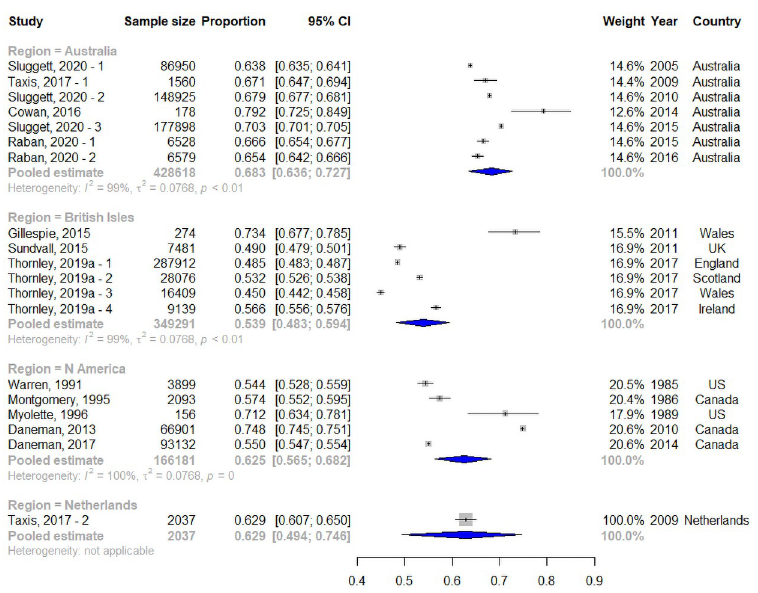
Fig 2. Meta-analysis by region of twelve-month period prevalence of antibiotic use. CI is confidence interval. Markers for individual studies are proportional to the studies’ weight in generating the region estimate.